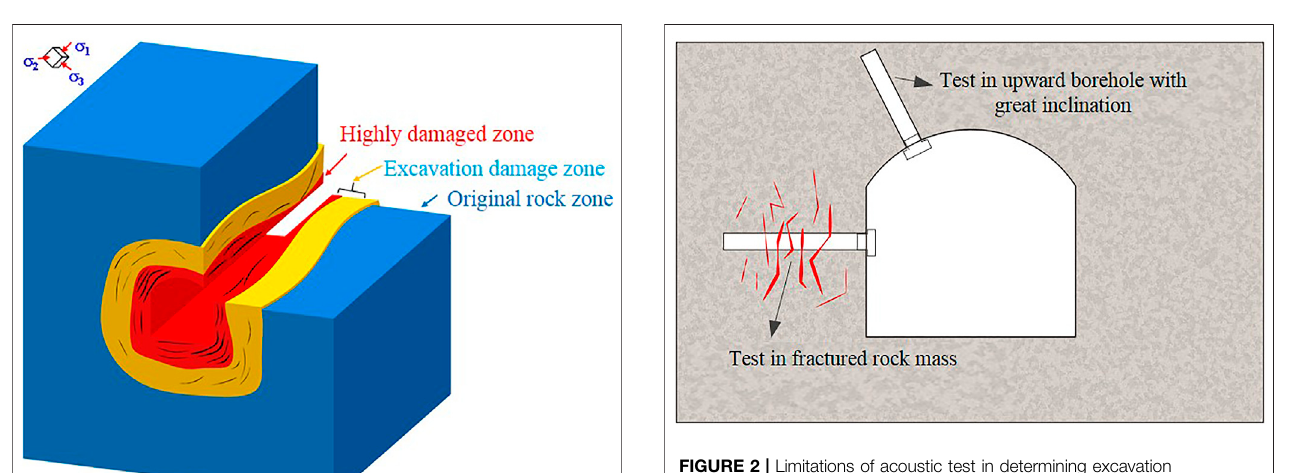
FIGURE 2 | Limitations of acoustic test in determining excavation damage